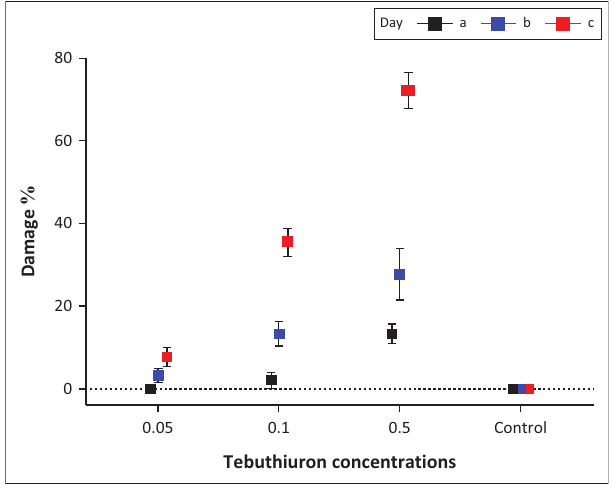
FIGURE 3: Growth reduction (% damage) caused to the grass species Tragus berteronianus by different tebuthiuron concentrations that were established in untreated (control) soil collected at site Puntberg. Observations for which data are presented here were made 14 days after treatment (14 DAT – ‘Day a’), 28 DAT (‘Day b’) and 56 DAT (‘Day